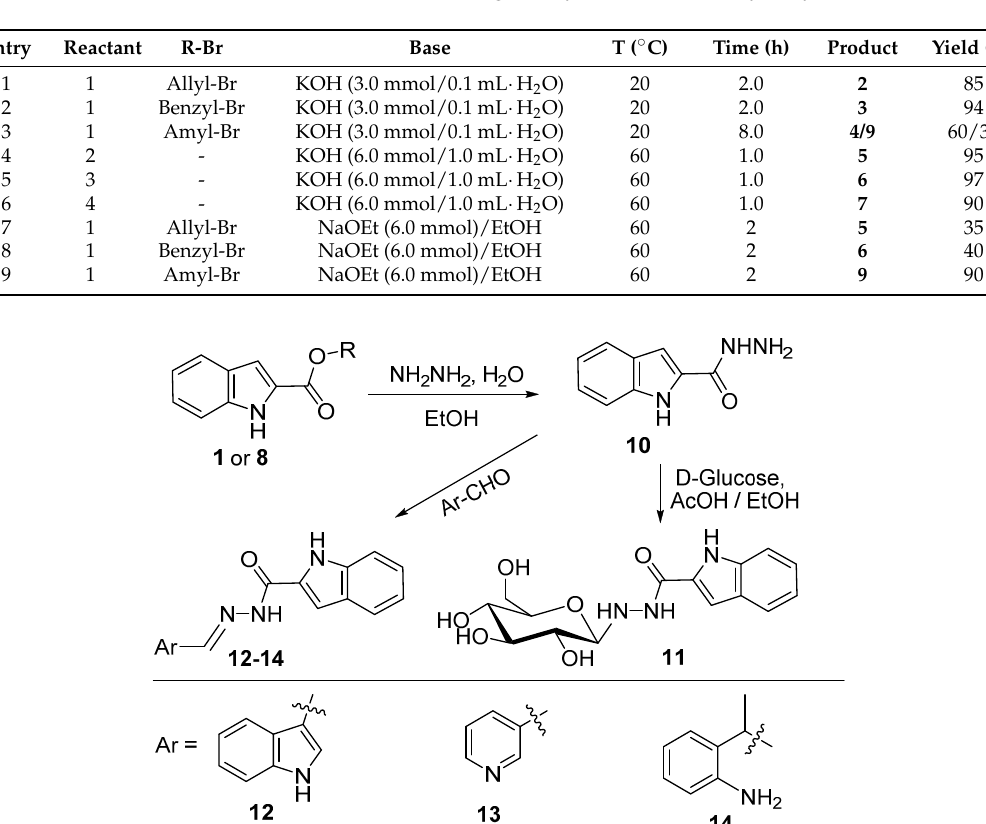
Scheme 1. Alkylation of indole nitrogen, transesterification and ester hydrolysis. Table 1. Conditions of indole nitrogen alkylation and ester hydrolysis.